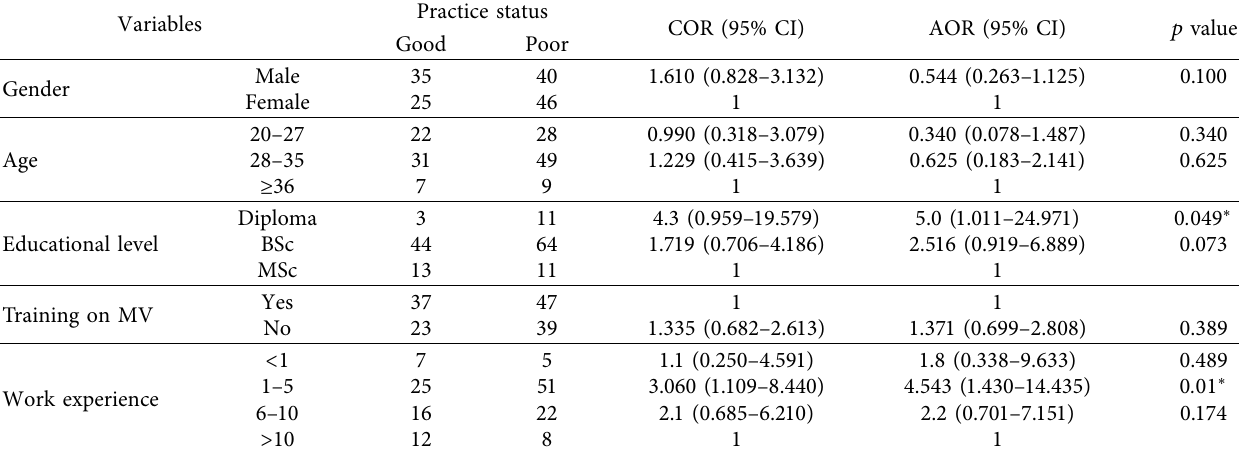
Table 5: Factors associated with the level of practice of nurses working in the ICU regarding mechanical ventilators ( N � 146).